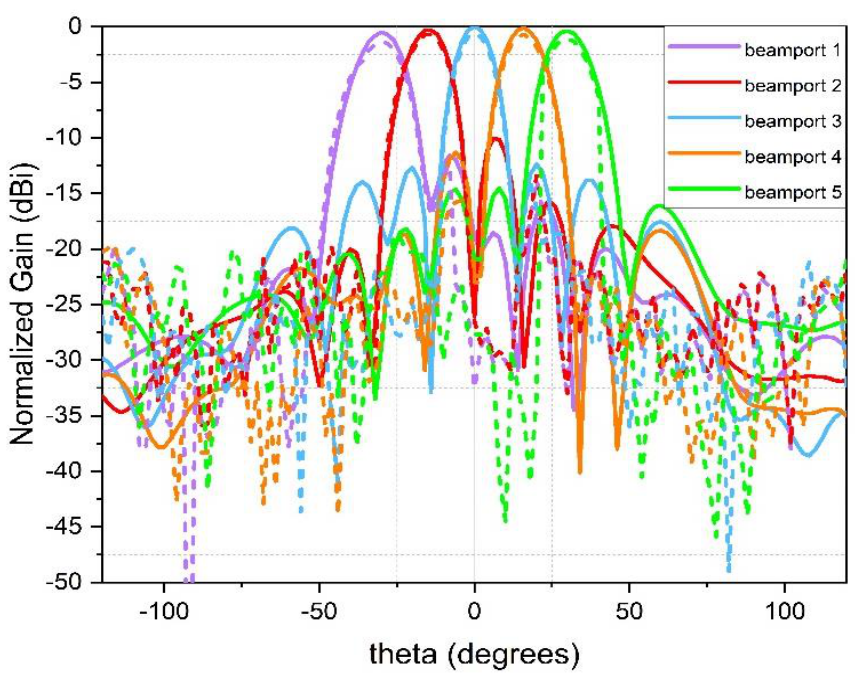
Figure 11. Measured (represented in dotted lines) and simulated (represented in plain lines) gain plots when beam ports are excited sequentially.